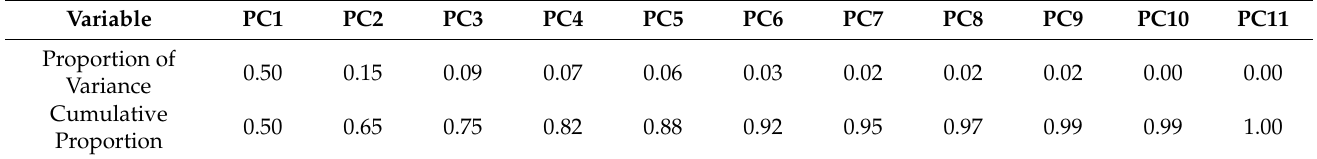
Table 4. Proportion of variance and cumulative proportion for each principal component.